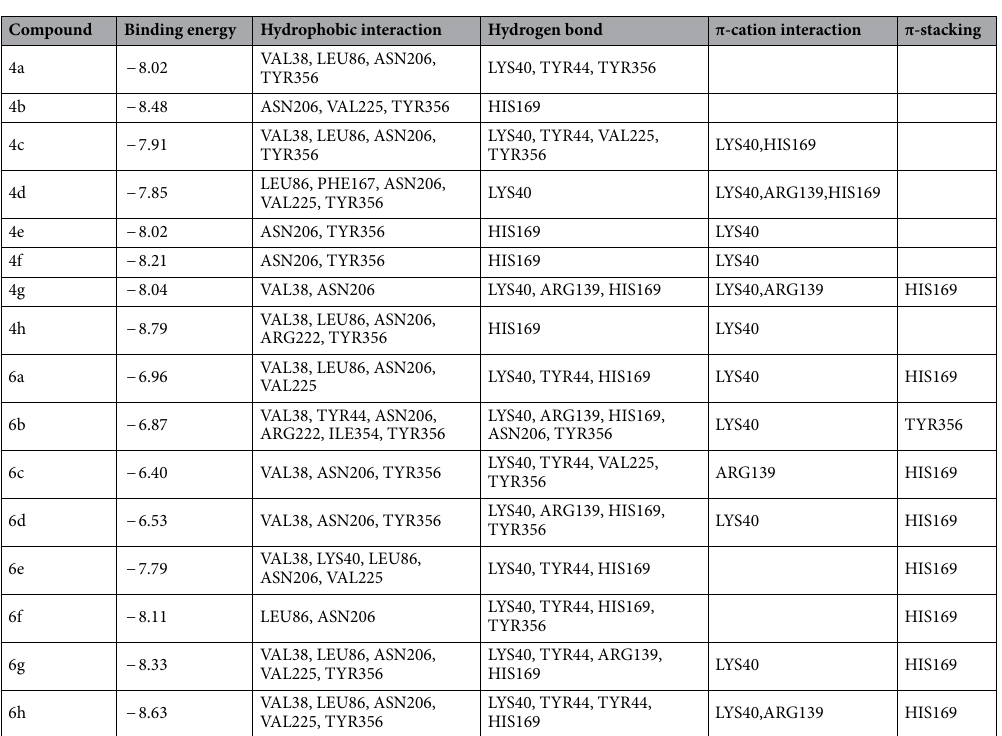
Figure 7. DPPH radical scavenging activity of synthesized compounds.